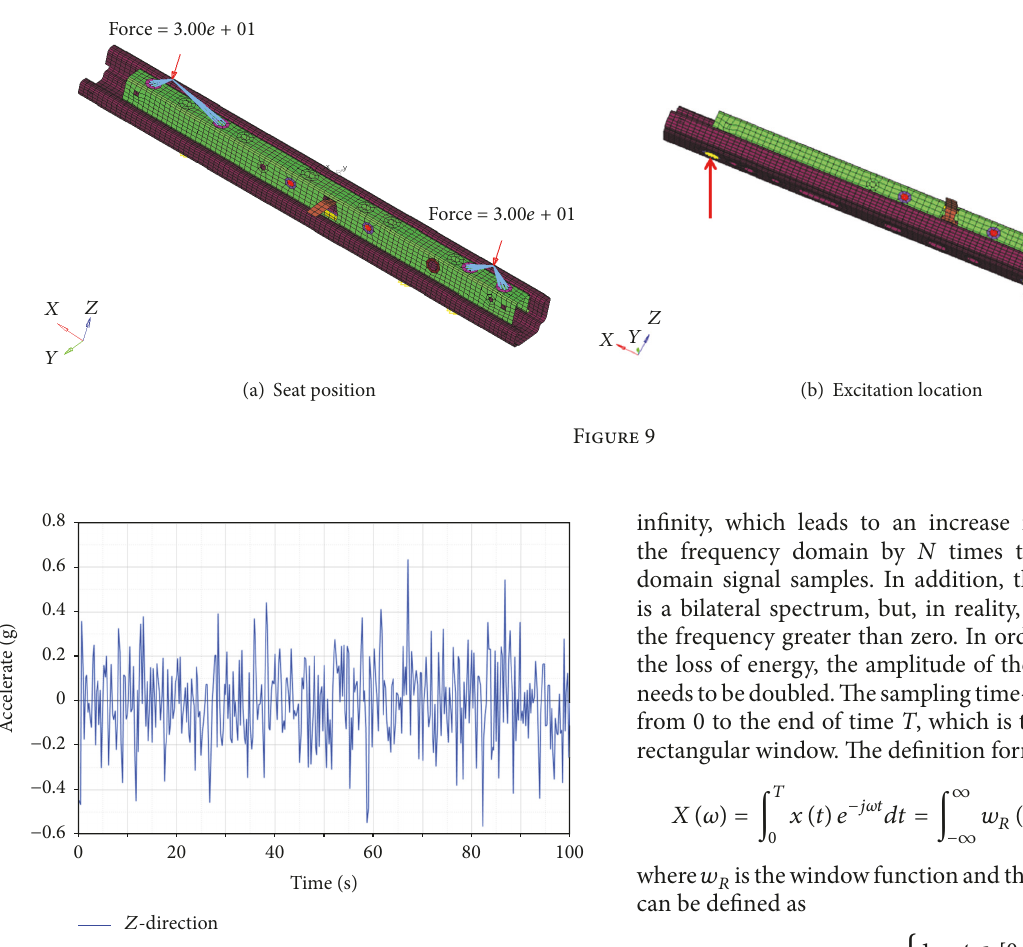
Figure 10: The 𝑧 direction spectrum collected when the vehicle speed is 60 km/h.